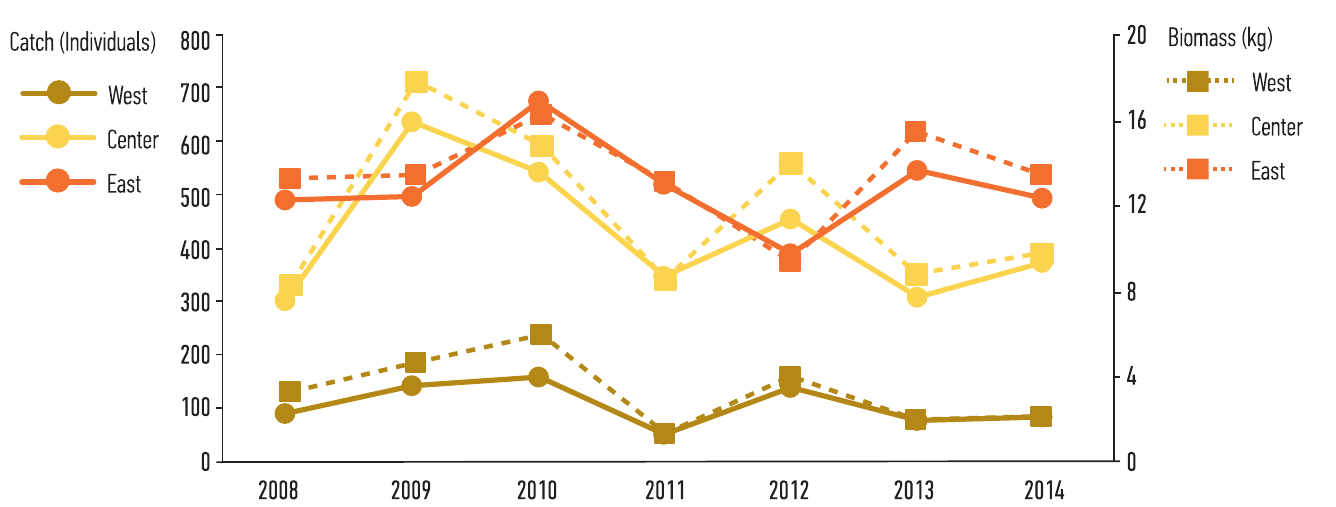
Mediterranean, Greece. Figure 2. Total Catch and Biomass of Nephrops captured in each sampling year and region of Pagasitikos Gulf, Eastern